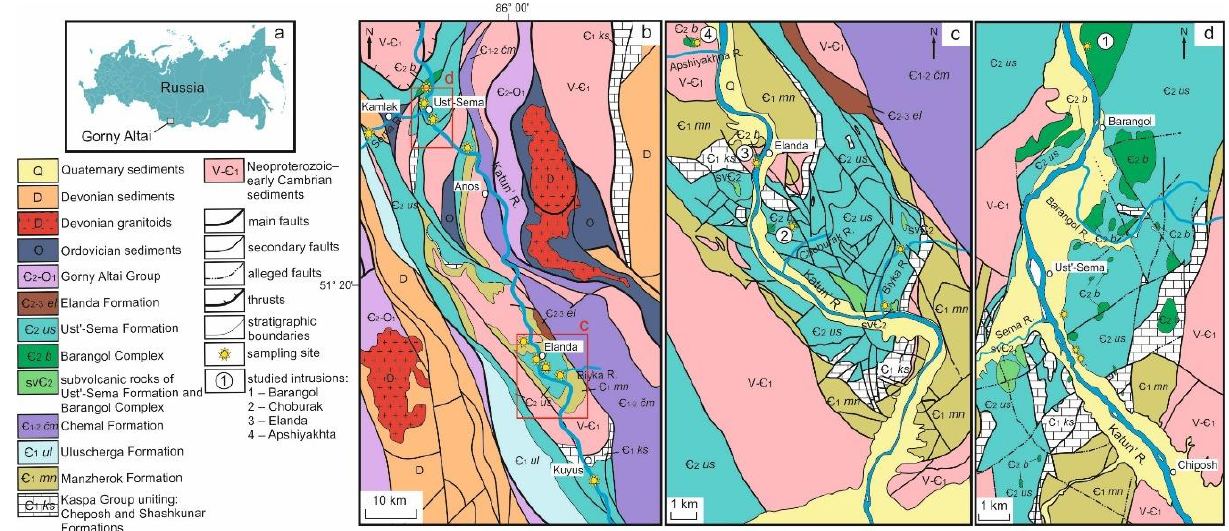
Figure 1. ( a ) Location map of Gorny Altai, Russia; ( b ) simplified geological map of northern Gorny Altai [20]; ( c ) geological map of the Biyka volcanic edifice of the Ust’ -Sema Formation [6]; ( d ) geo- logical map of the Ust’ - Sema volcanic edifice of the Ust’ -Sema Formation